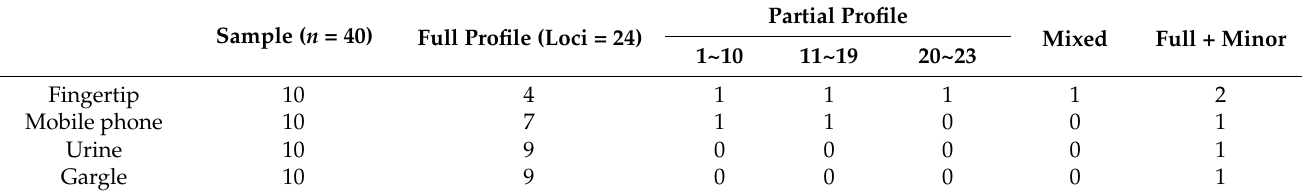
Table 1. Results of STR